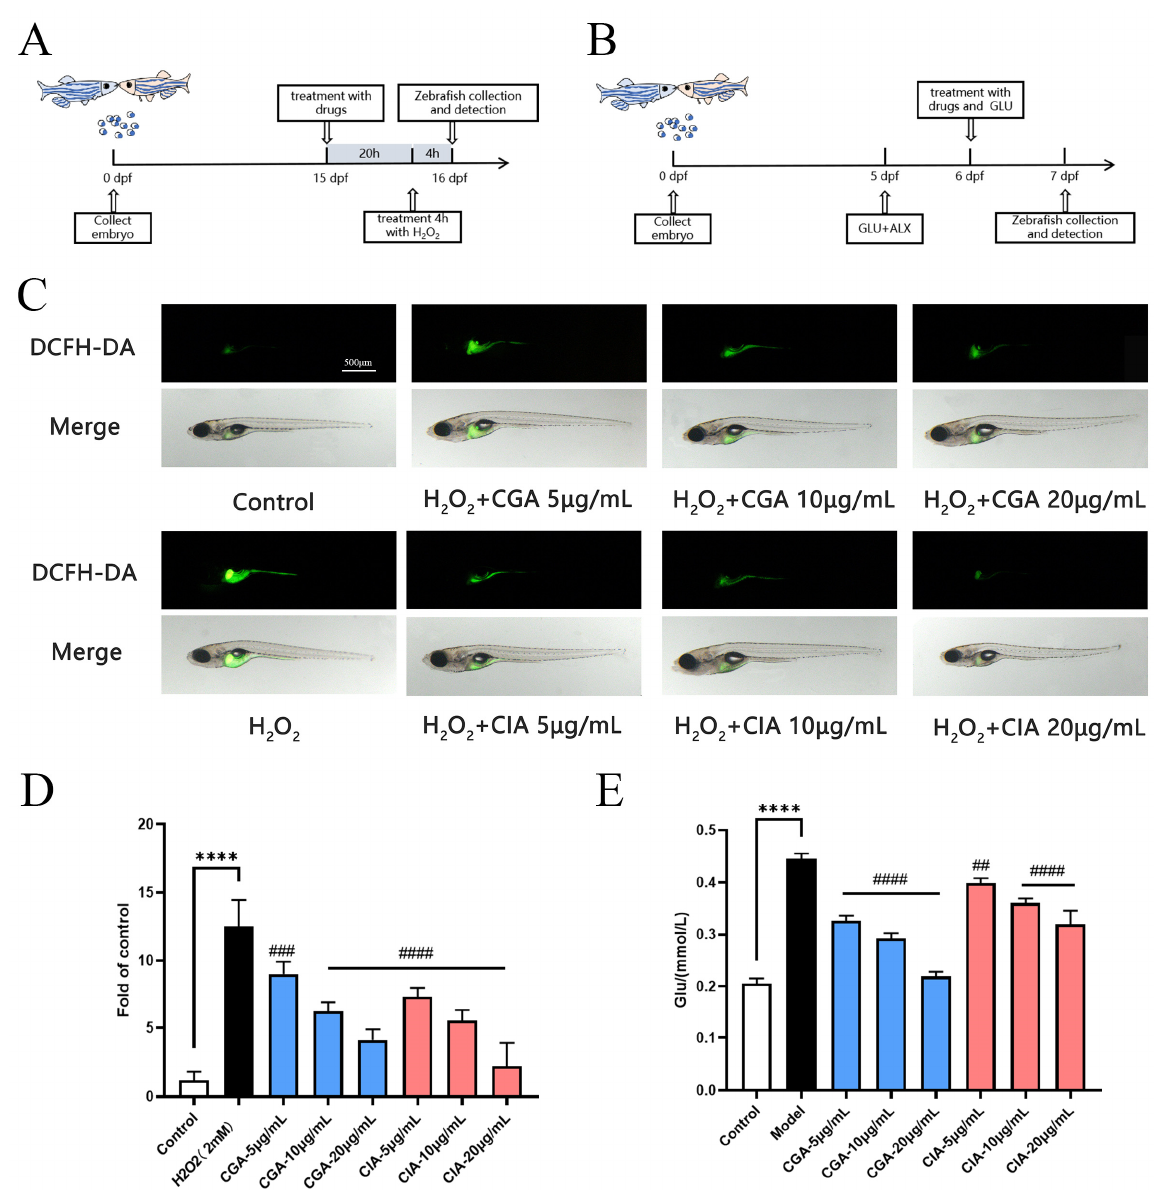
Figure 4. Effect of CGA and CIA on antioxidative and hypoglycemic activities in larval zebrafish. ( A ) Experimental outline of H 2 O 2 induced larval zebrafish. ( B ) Experimental outline of GLU+ALX induced larval zebrafish. ( C ) ROS production showed in fluorescence image and merged with light field image. ( D ) ROS level quantitated by fluorescence quantitative data. ( E ) Glucose levels of each treated larval group. Bar indicates means ± SD. **** p < 0.0001 compared with control; ## p < 0.01, ### p < 0.001, #### p < 0.0001 compared with model. p < 0.05 was considered as statistical significance calculated by ANOVA followed by Tukey’s test.